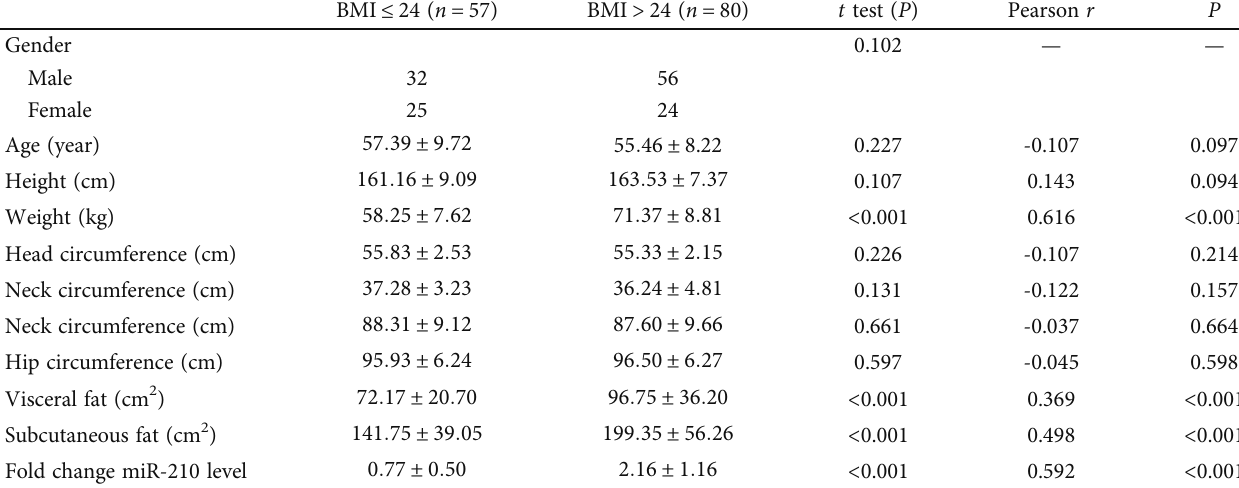
Table 1: The di ff erences and correlation of demographic, general characteristics, and miR-210 level between BMI ≤ 24 and BMI > 24 groups in patients with type 2 diabetes